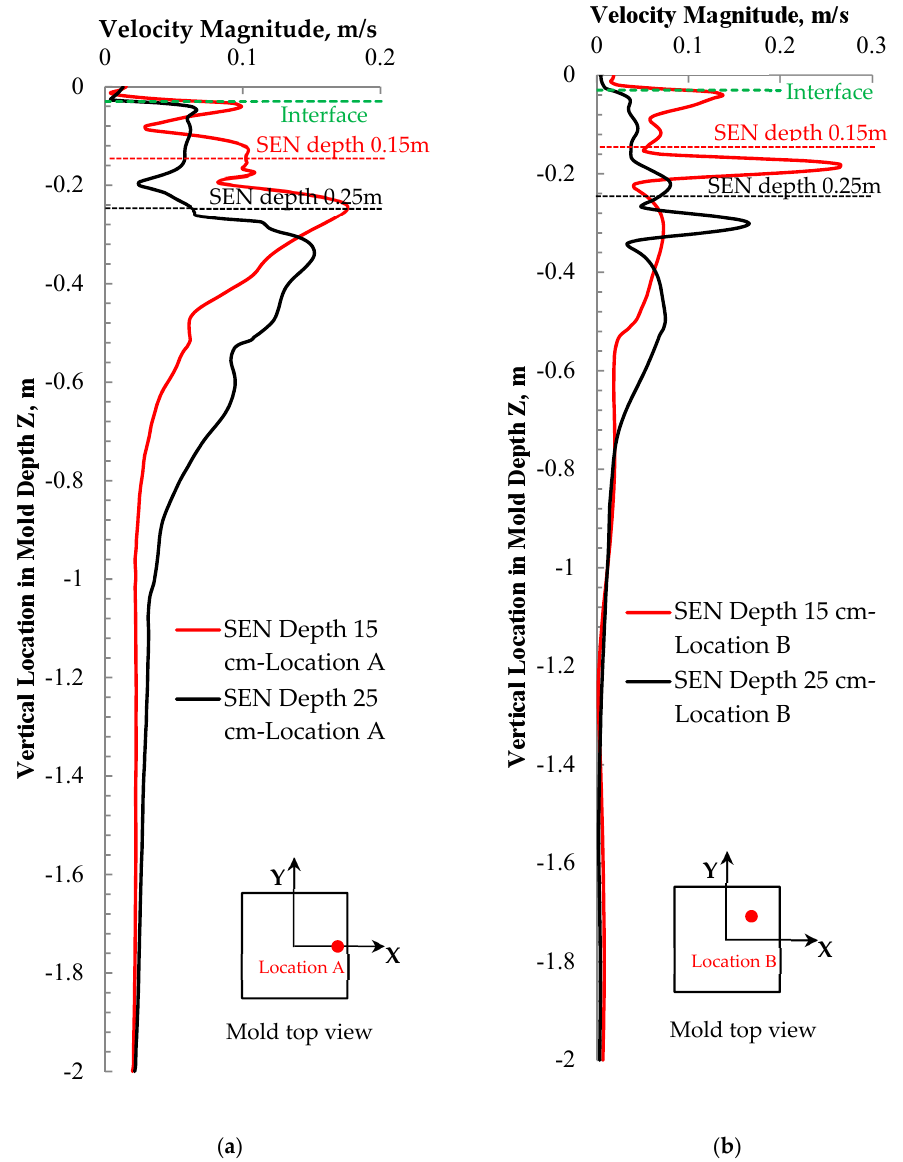
Figure 7. Total velocity distribution along different lines in mold depth direction, ( a ) Location A with 1 cm away from the wall and ( b ) Location B in the center of the top-right one quarter cross section.